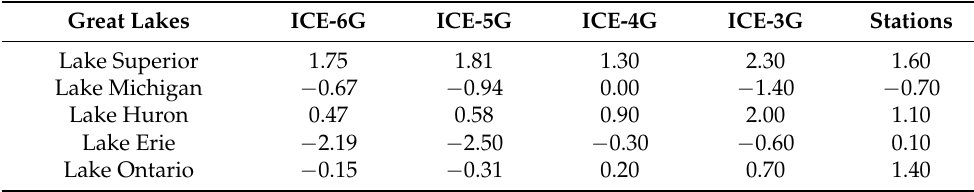
Table 3. Comparison of averaged radial displacement from ICE-6G, ICE-5G, ICE-4G, ICE-3G, and water level stations, respectively, over the Great Lakes. The data for water level stations’ relative vertical motion is from [8].